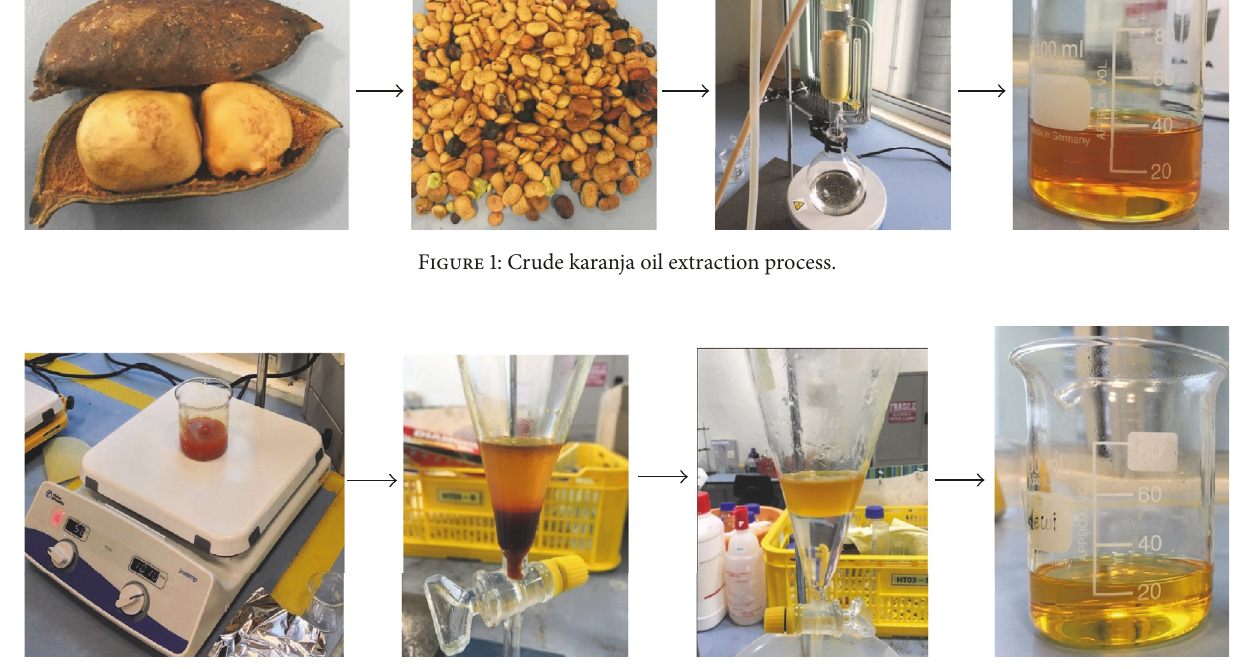
Figure 2: Karanja biodiesel production by transesterification.